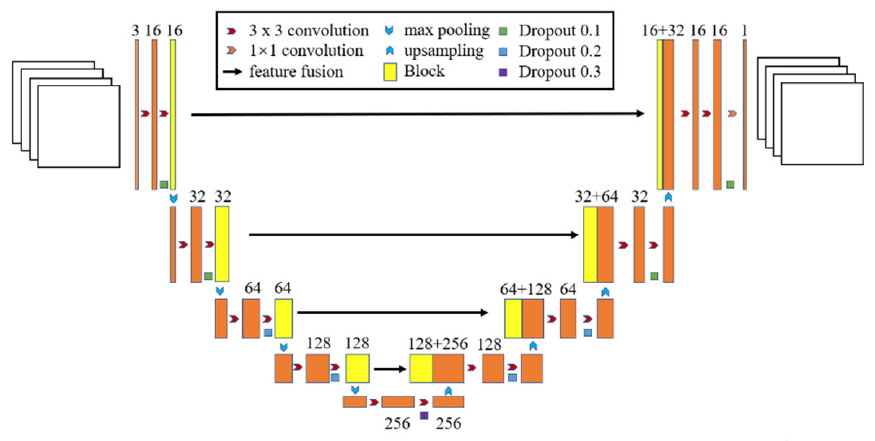
Figure 1. The U-Net structure.